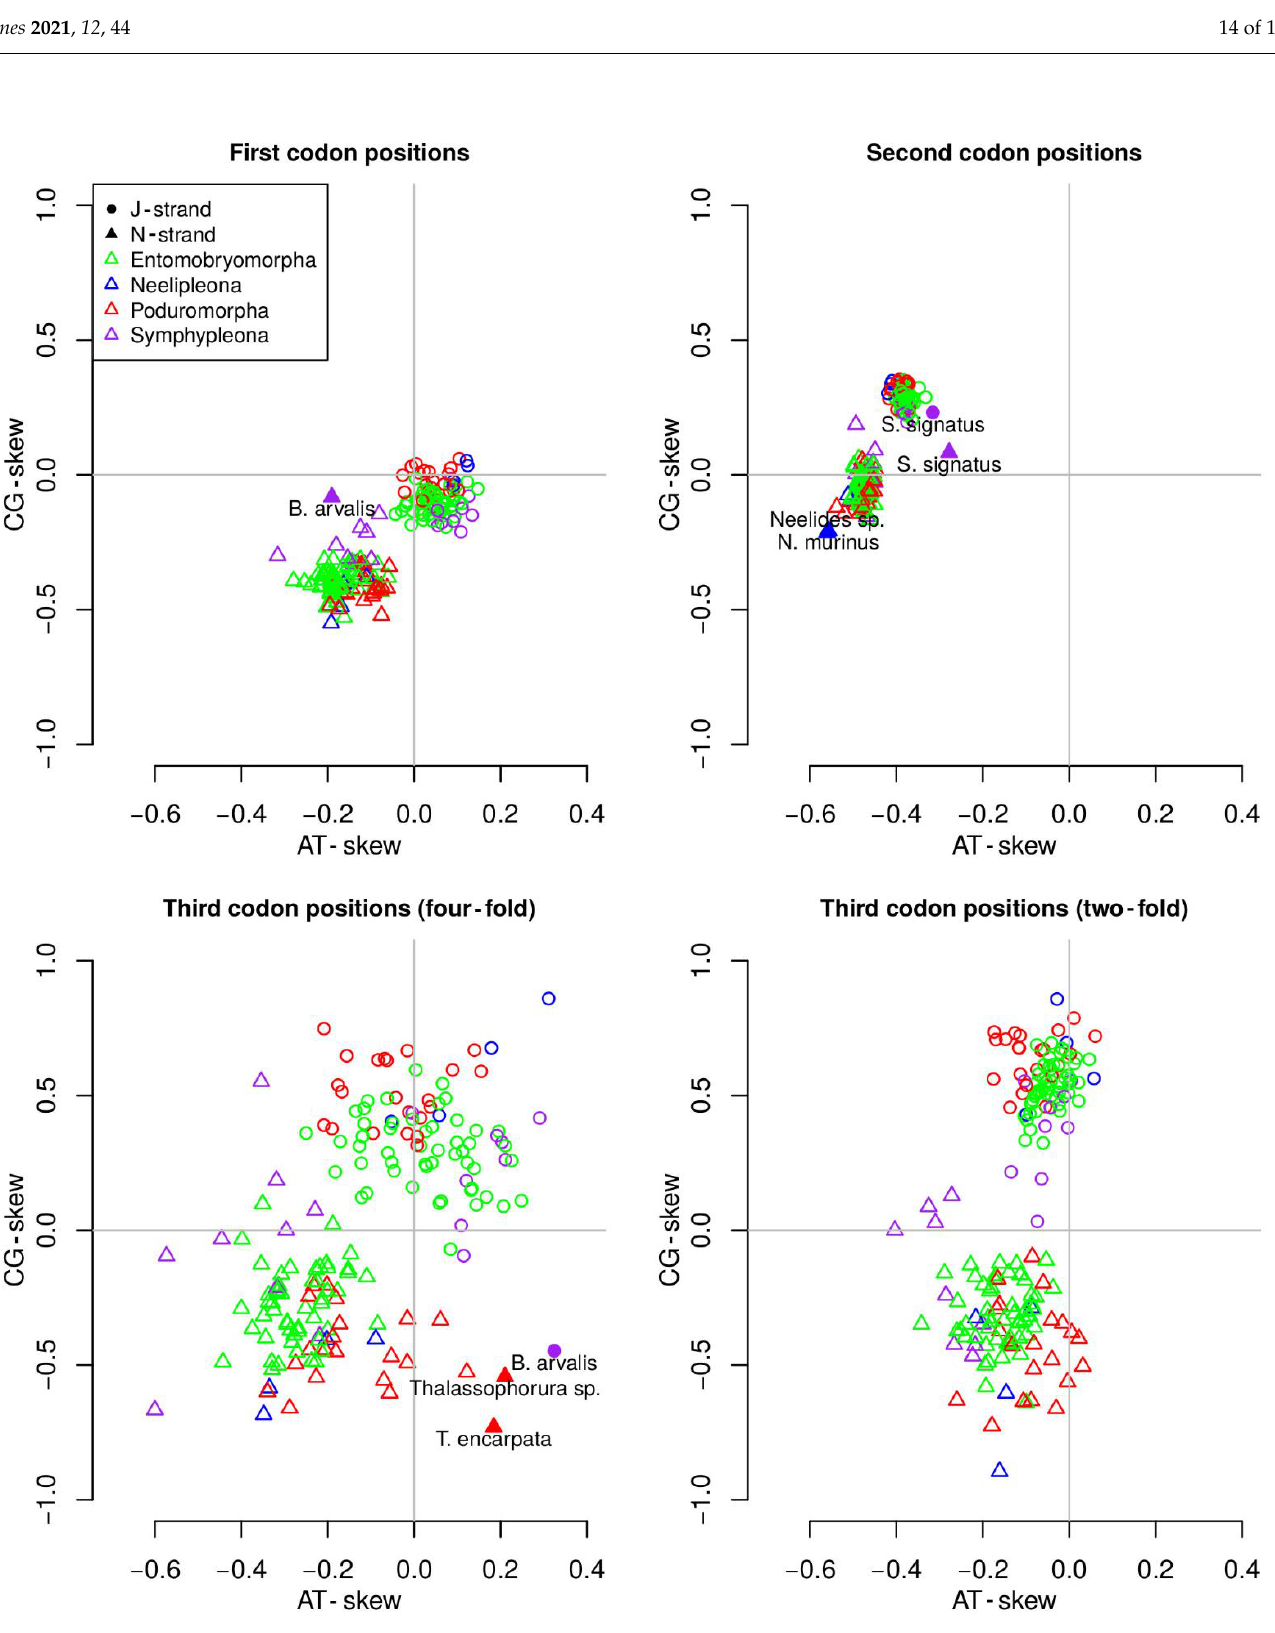
Figure 6. Single base skews for all available Collembola mitogenomes. Orders are color-coded and J- and N-strands are coded by shape. Outliers are identified by species name.